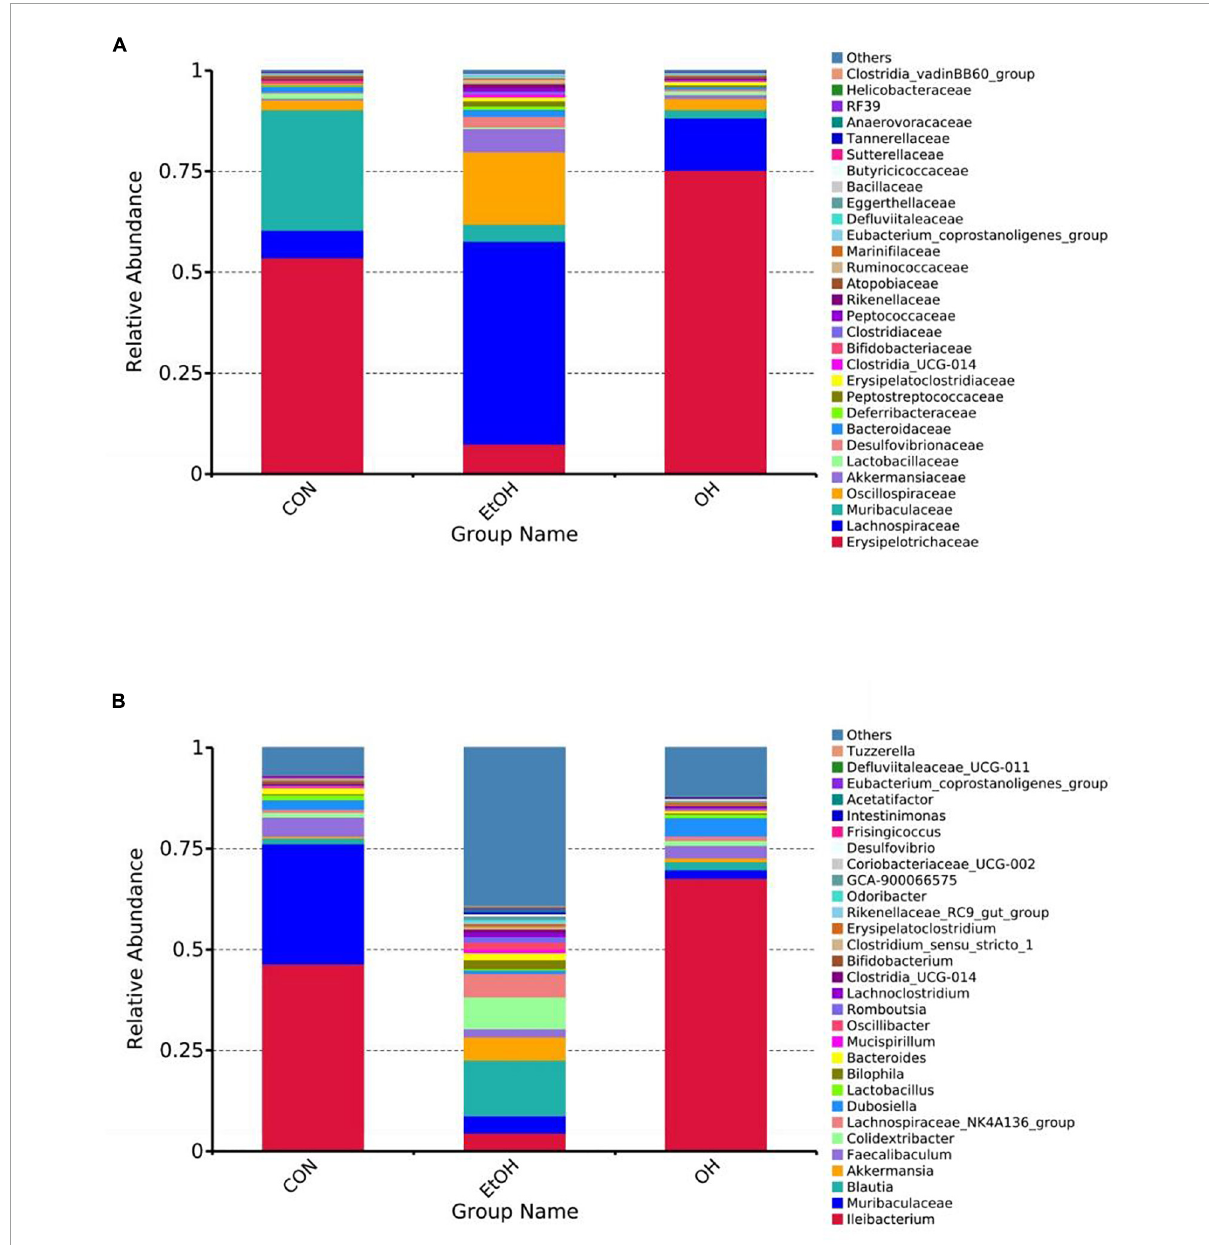
FIGURE7 Effect of OEB treatment on gut microbiota. (A) Gut microbiota composition at the family level and (B) Gut microbiota composition at the genus level. CON, control group; EtOH, ethanol administration group and OH, high-dose OEB